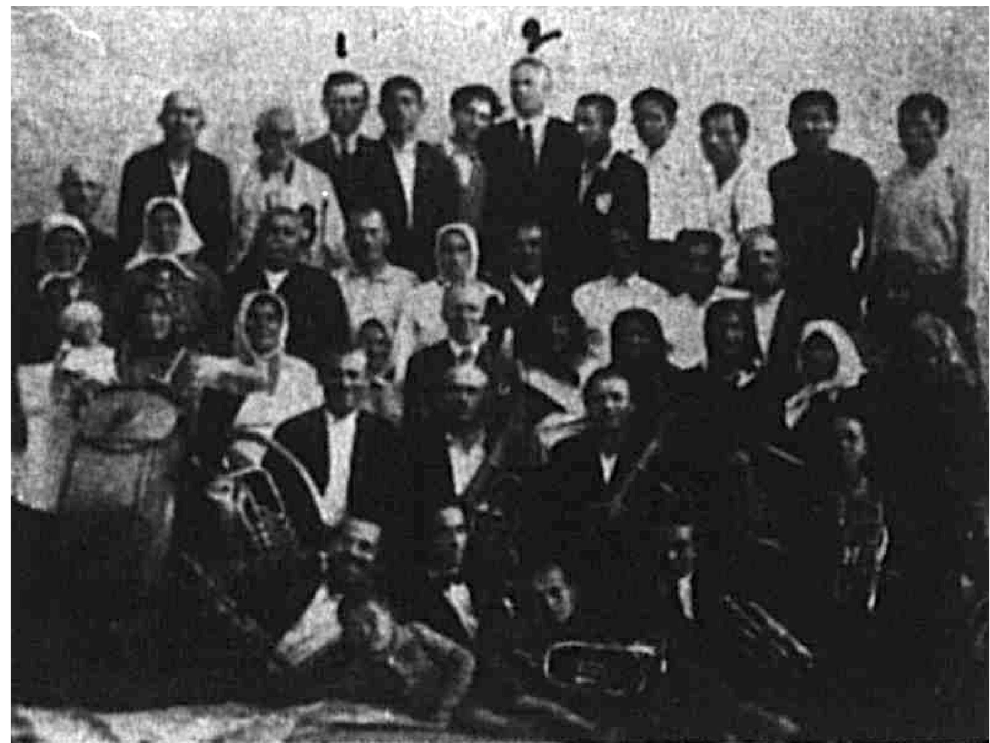
Figure 1. Faith Church members in 1932. Source: Craighead (1932, p. 1). Notes: (1) Ioan Cocut, (2) Dumitru Vrânceanu, and (4, below Dumitru Vrânceanu, on the left) Walter Craighead. The Roma lay leader (3, upper line, second from the left) is perhaps Anton